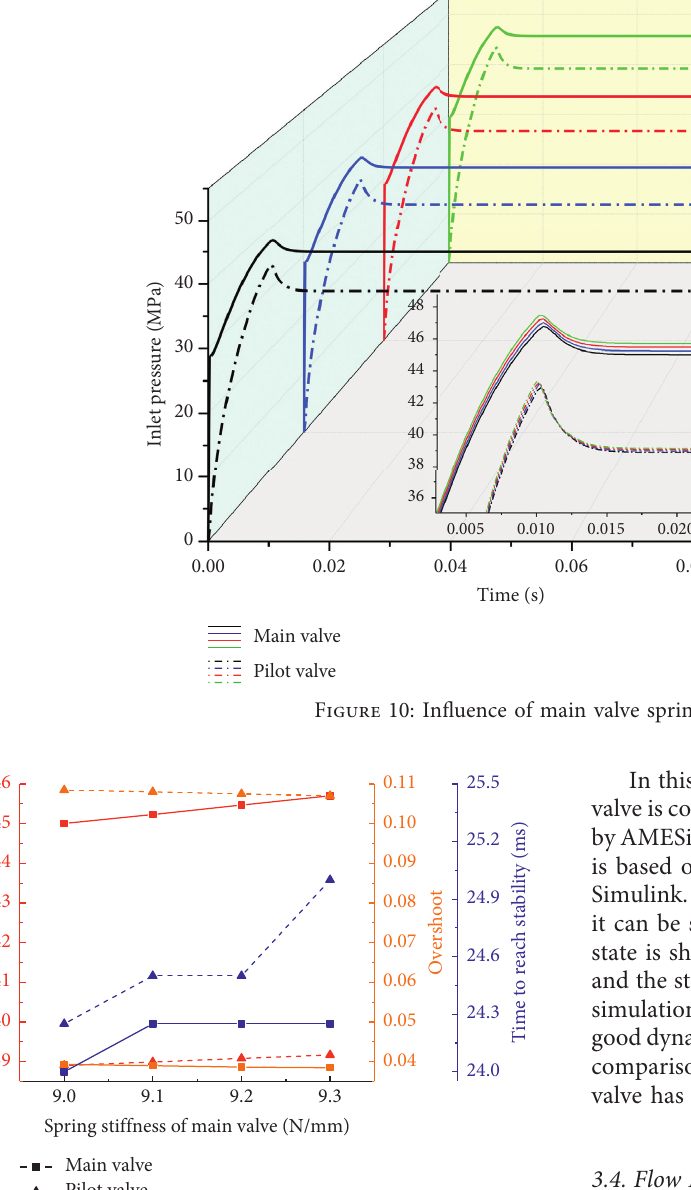
Figure 11: Dynamic response